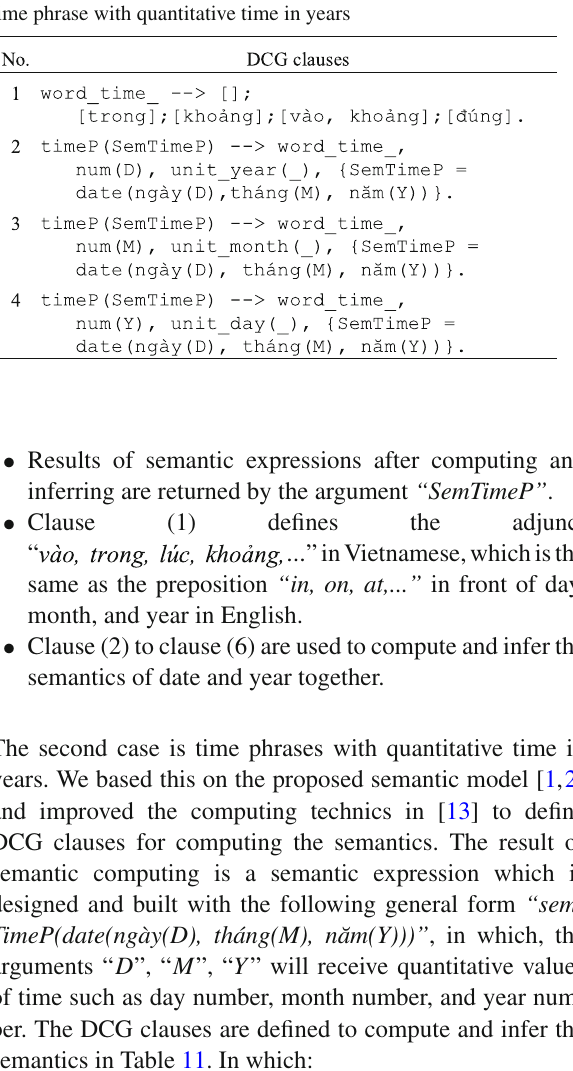
Table 9 DCG clauses define number and unit of day–month–year